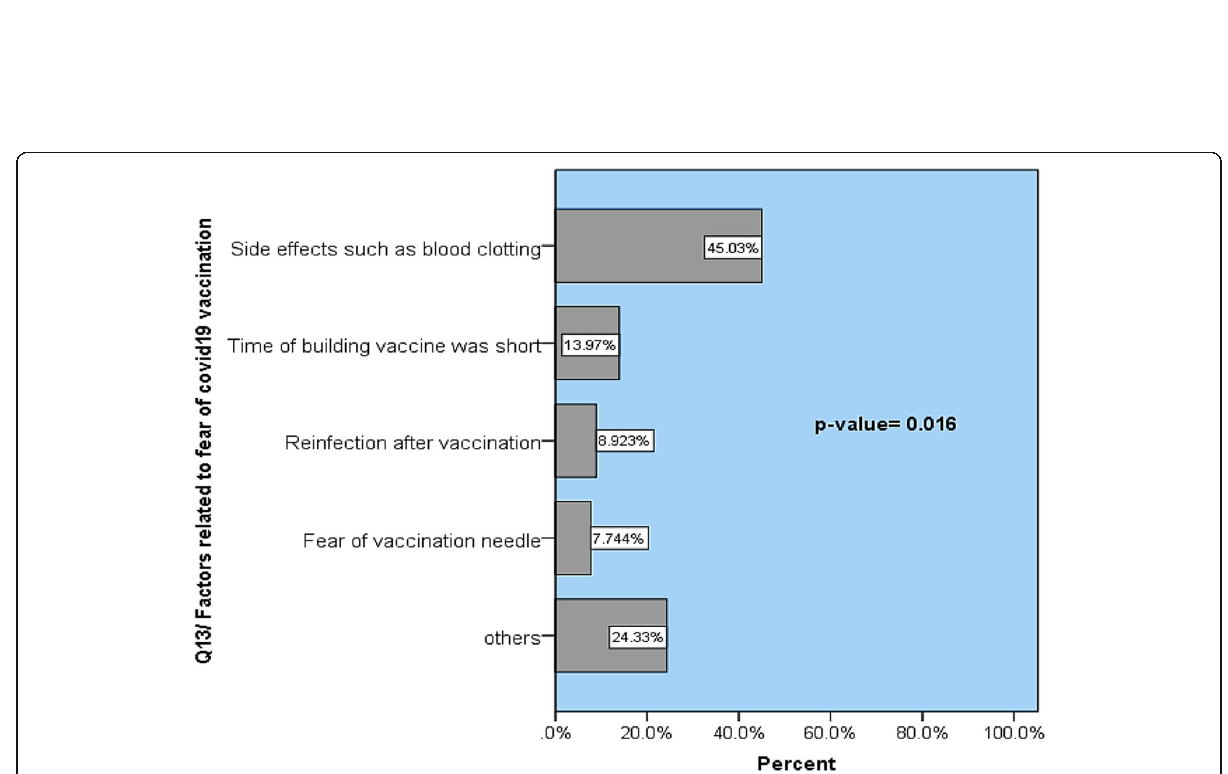
Fig. 3 Reasons affecting fear of COVID-19